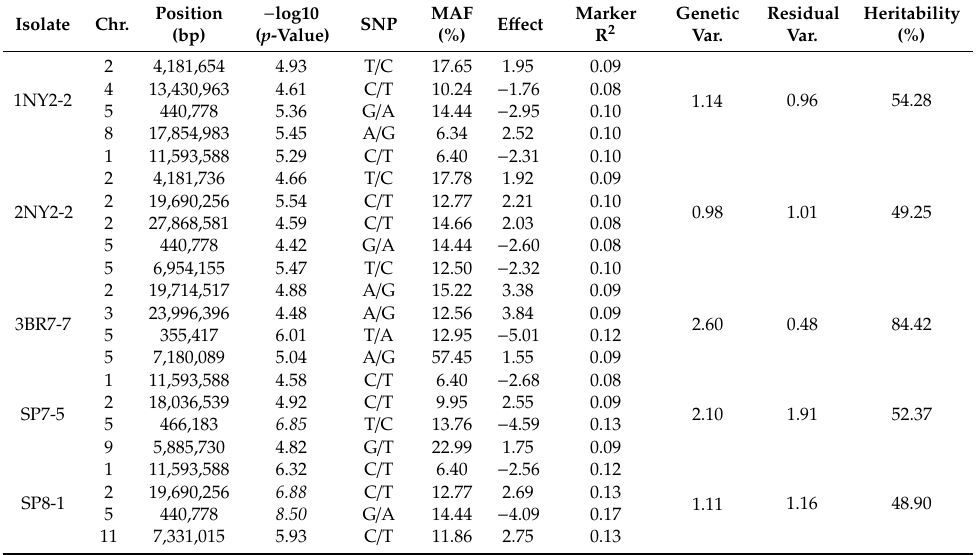
Table 1. The single-nucleotide polymorphisms (SNPs) that are associated with bacterial leaf streak (BLS) resistance to five Xoc isolates.